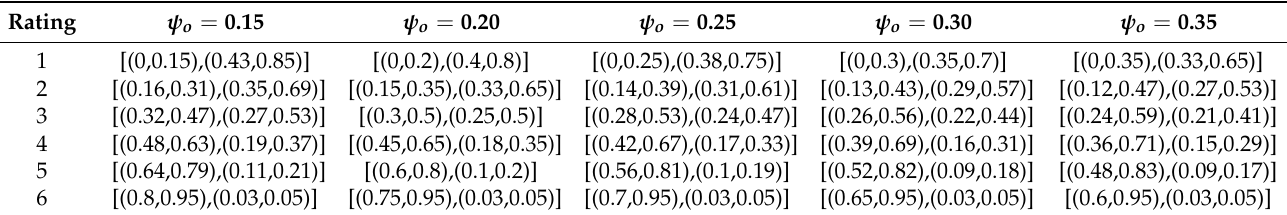
Table 19. Resulting IVIFS values for the case of assigning restaurants.